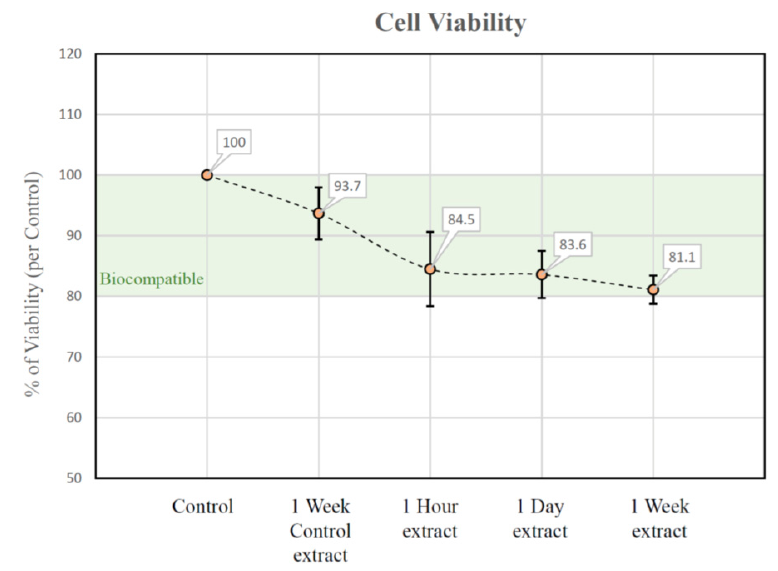
Figure 4. Results of MTT cell vitality assay for negative control, positive control, and test samples after 1 h, 1 day, and 1 week.